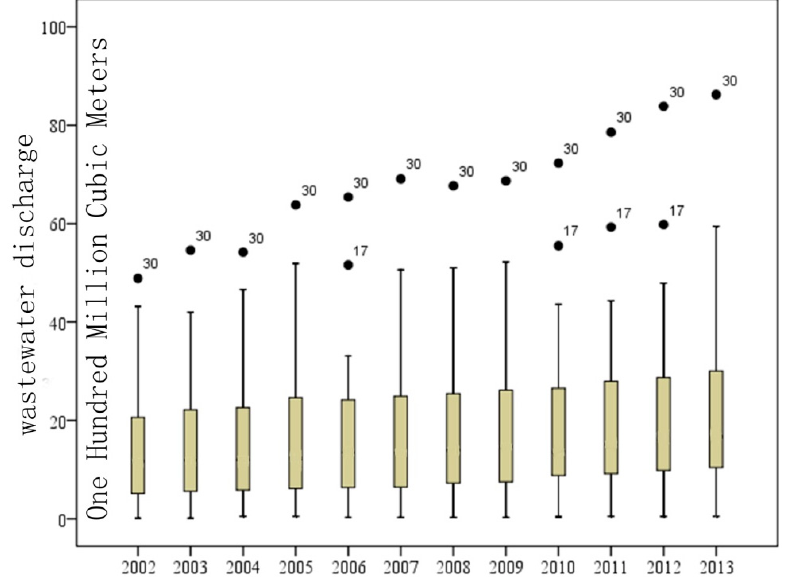
Figure 2. Provincial inter-annual variability of the wastewater discharge in China, 2002–2013 (the upper limit and the lower limit of each box are within the range of the normal value. The two ends of the rectangle box correspond with four quantizes, the line in the middle is the median; Thirty and seventeen are the abnormal points, representing Guangdong Province and Jiangsu Province respectively).